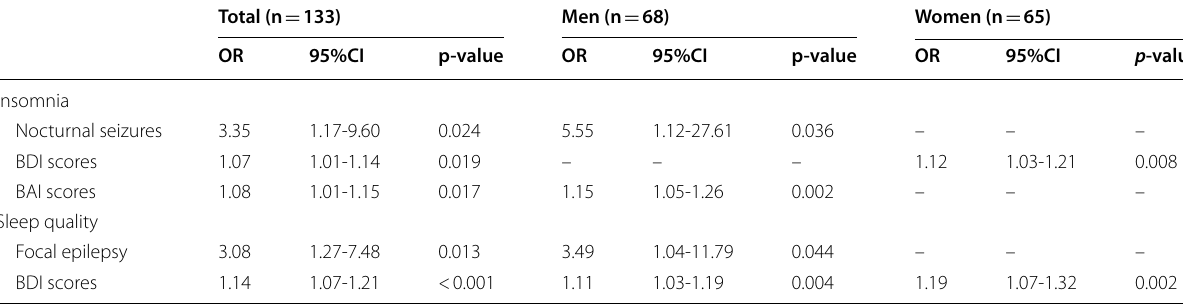
The p-values are obtained from logistic regression analysis OR odds ratio, CI Confidence Interval, BDI Beck Depression Inventory, BAI Beck Anxiety Inventory